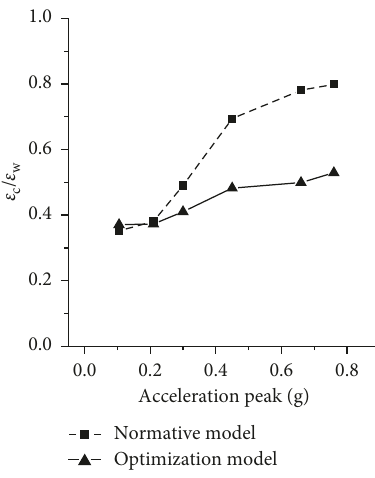
Figure 15: Strain ratio of column and wall